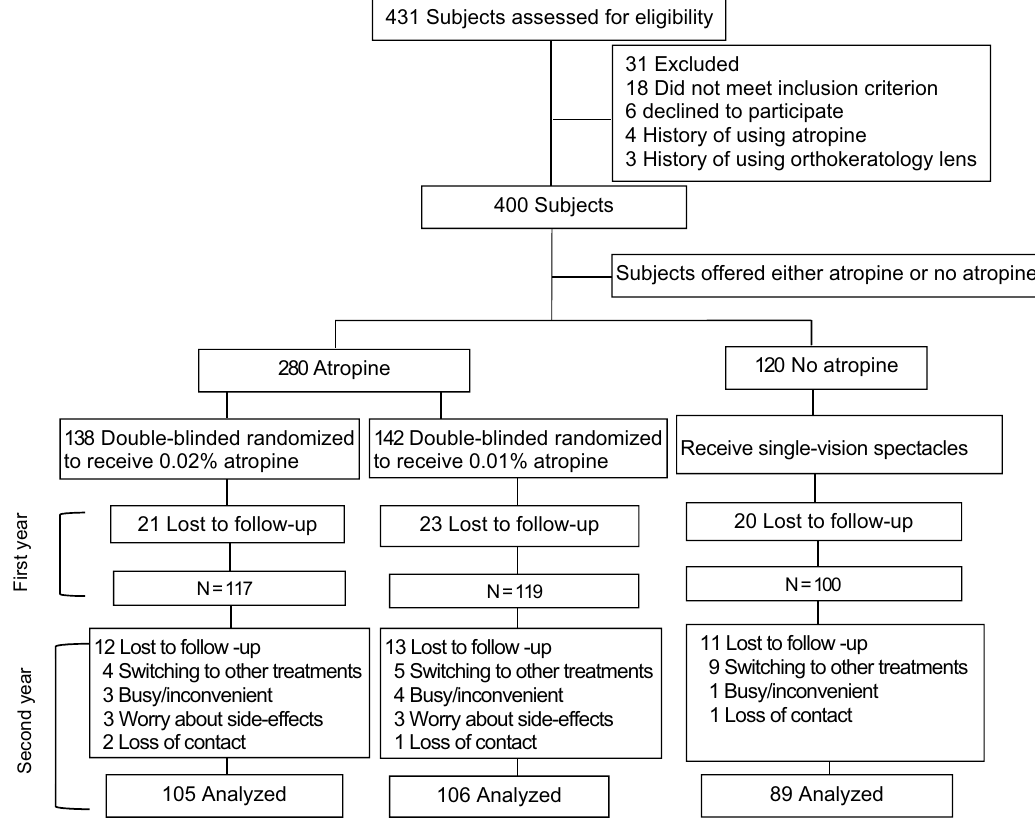
Figure 1. Subject recruitment and randomization